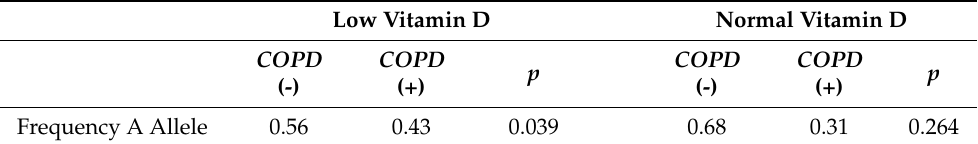
Table 4. Frequency of A allele according to vitamin D and chronic obstructive pulmonary disease statuses.